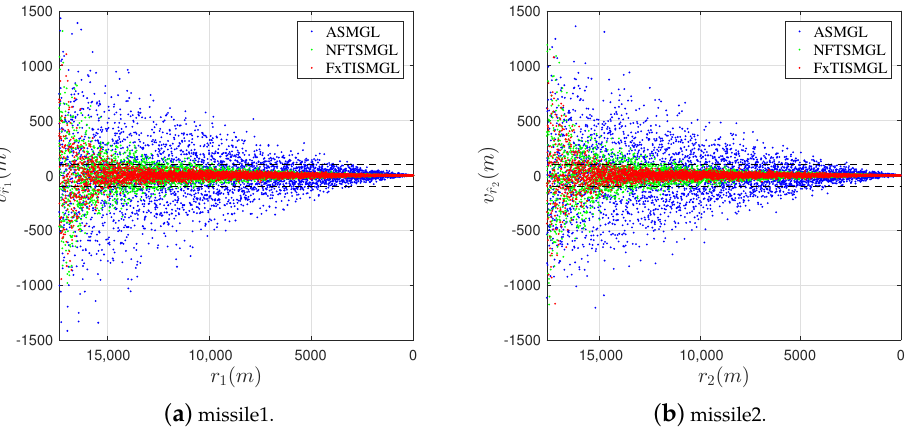
Figure 8. The measurement errors of the missile-target range. Black dashed line: 100 m.